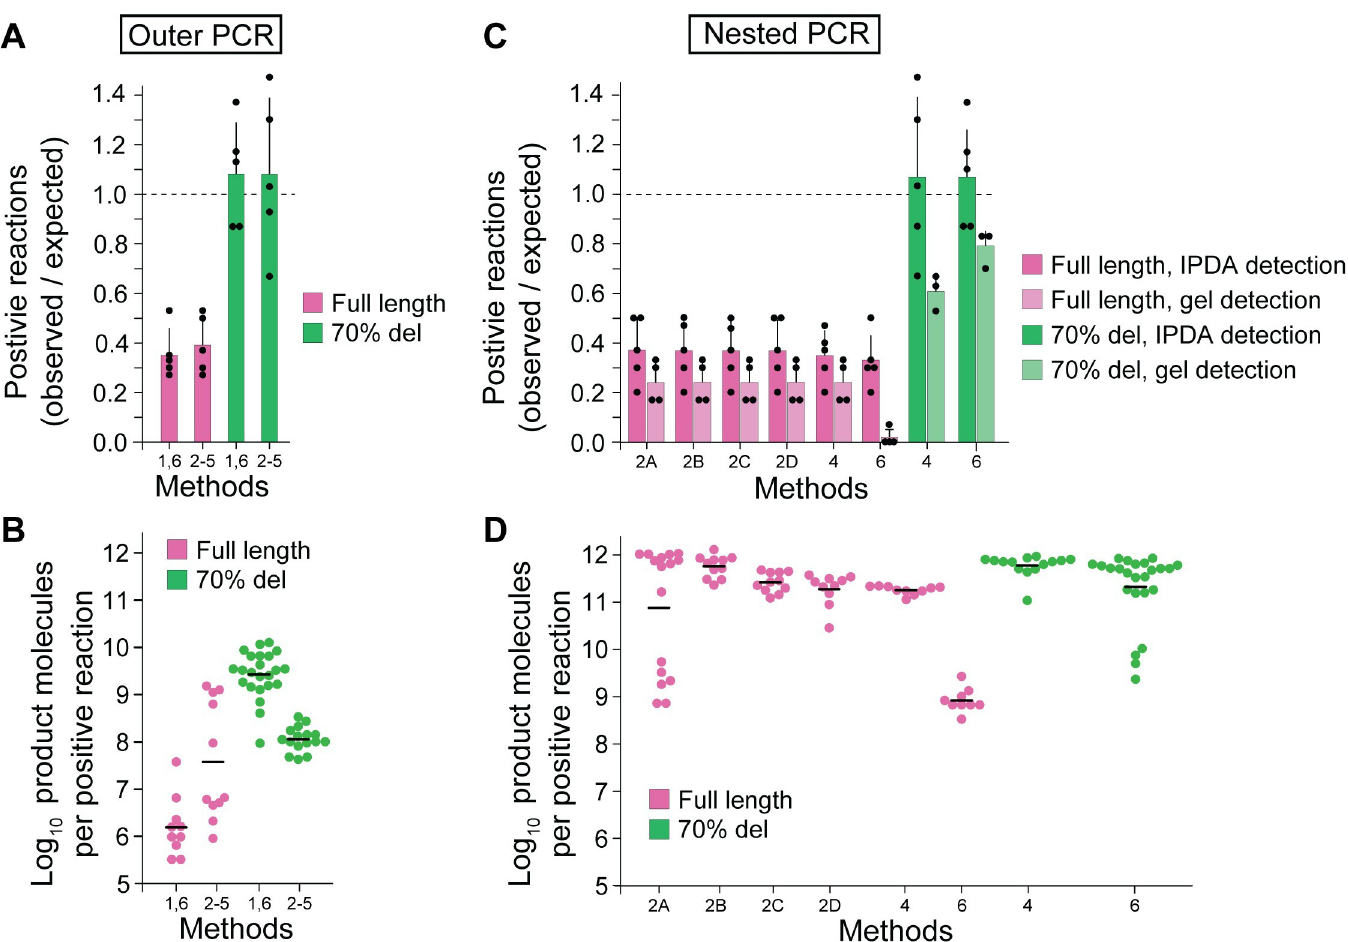
Fig 4. Amplification of full length and deleted proviruses by different nFGS methods. ( A ) Number of limiting dilution outer PCRs that are positive for amplification of full length and deleted proviruses by different nFGS methods. Carefully quantitated proviral constructs diluted into HIV-1 negative DNA were plated at 30 proviruses/96 well plate. After amplification under conditions used by Methods 1 and 6 or Methods 2–5 (see S1 Table ), the fraction of wells with amplification was determined by IPDA. Results are expressed as the number of positive reactions per 96 well plate divided by the expected value (30/plate) for each of 5 plates (black circles). The means and standard deviations for the 5 plates tested per condition are shown as bars and black lines, respectively. The expected number of positive wells (dashed line) was observed for the proviral construct with a large internal deletion representing 70% of the genome (green bars) but not for the full-length provirus (pink bars). ( B ) Number of product molecules generated in the positive PCRs from A . Aliquots from positive wells from a representative plate were diluted extensively and analyzed by IPDA for digital counting of product molecules as described in Fig 1E–1H . Black lines show the geometric mean values. ( C ) Number of limiting dilution nested PCRs that are positive for full length and deleted proviral constructs amplified by different nFGS methods. After outer and nested amplification for under indicated conditions (see Fig 2C and 2D and S1 Table ), the fraction of wells with amplification was determined by IPDA. Results are expressed as the fraction of positive wells relative to the expected value (30/plate) as described in A . In addition, 45 ul aliquots of nested PCR wells were analyzed by agarose gel electrophoresis, and the number of wells with visible bands was determined and plotted in the same manner (light colors). ( D ) Number of product molecules generated in the positive PCRs from a representative plate in C . Aliquots from positive wells were diluted extensively and analyzed by IPDA for digital counting of product molecules as described in B . Black lines show the geometric mean